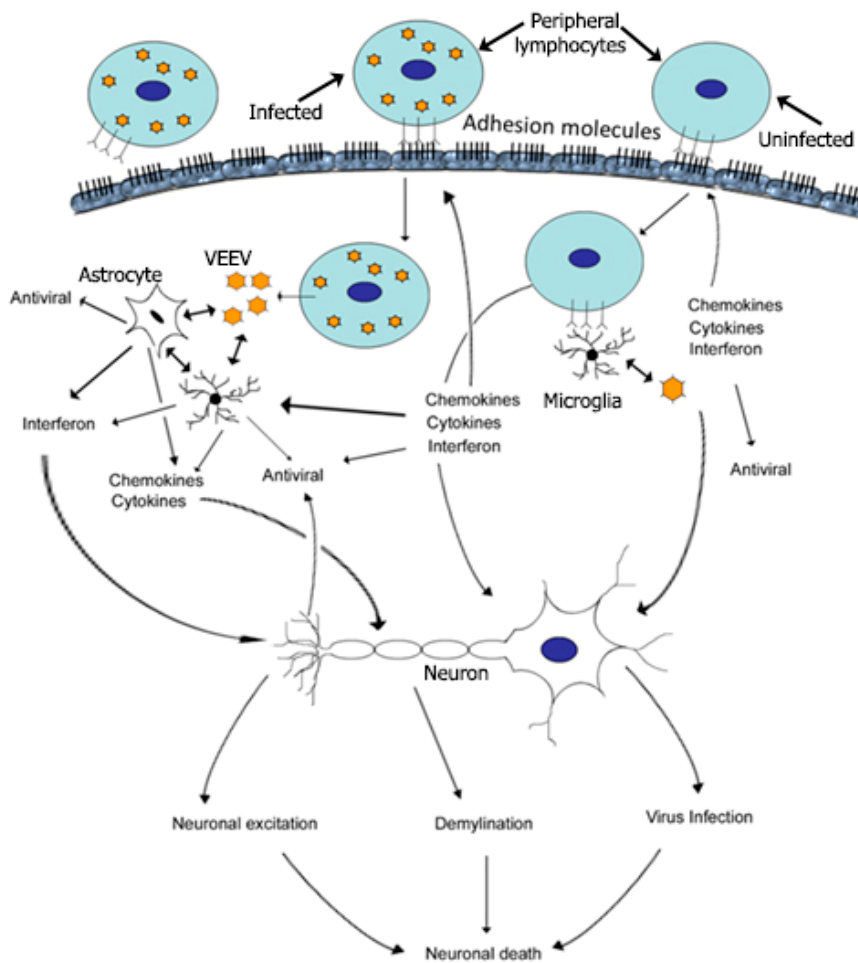
Figure 5. Role of BBB in VEE. Endothelium of the BBB is actively involved in the